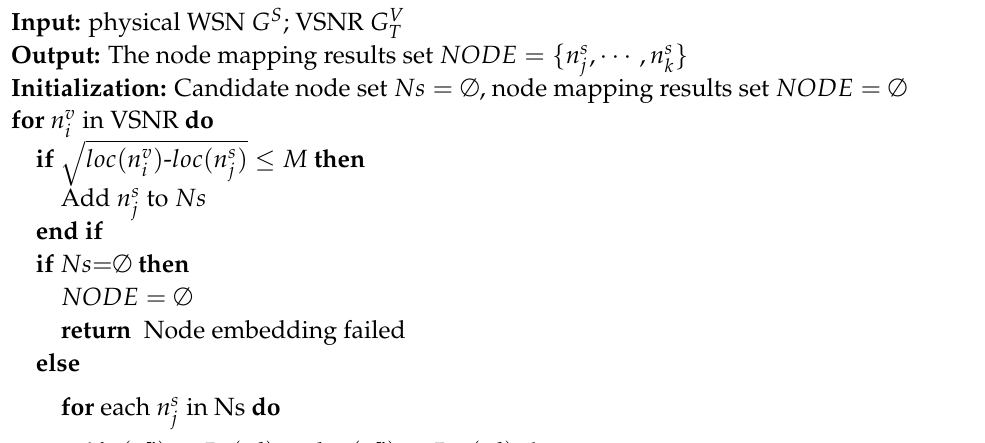
Algorithm 1 Node reliability-aware backup survivable embedding algorithm